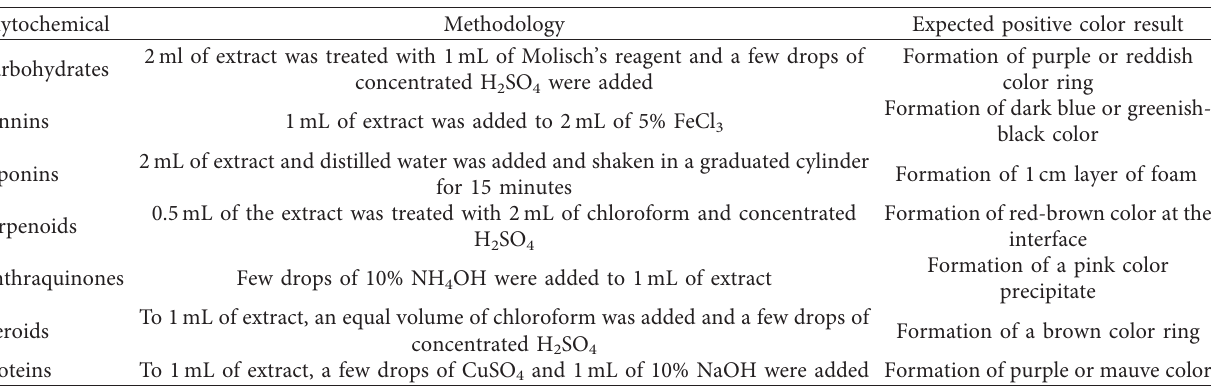
Figure 6: Five varieties of Catharanthus roseus flowers and their code names. (LPF) Light pink (a), (RF) red (b), (WPF) white pink dot (c), (WYF) white yellow dot (d), and (PF) purple (e). Table 1: Methodology of the phytochemical analysis [20].